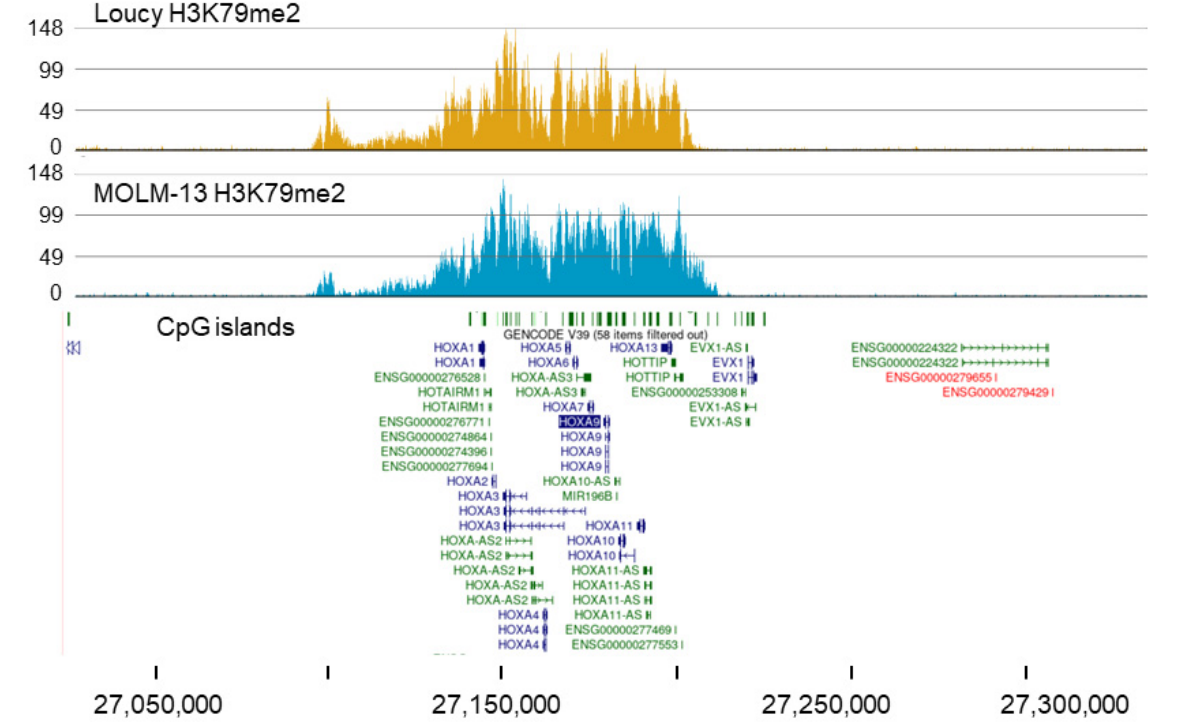
Figure 5. Broad H3K79me2 domain with the HOXA9 gene in Loucy cells. The panel shows the H3K79me2 ChIP-Seq tracks for HOXA9 in MOLM-13 and Loucy